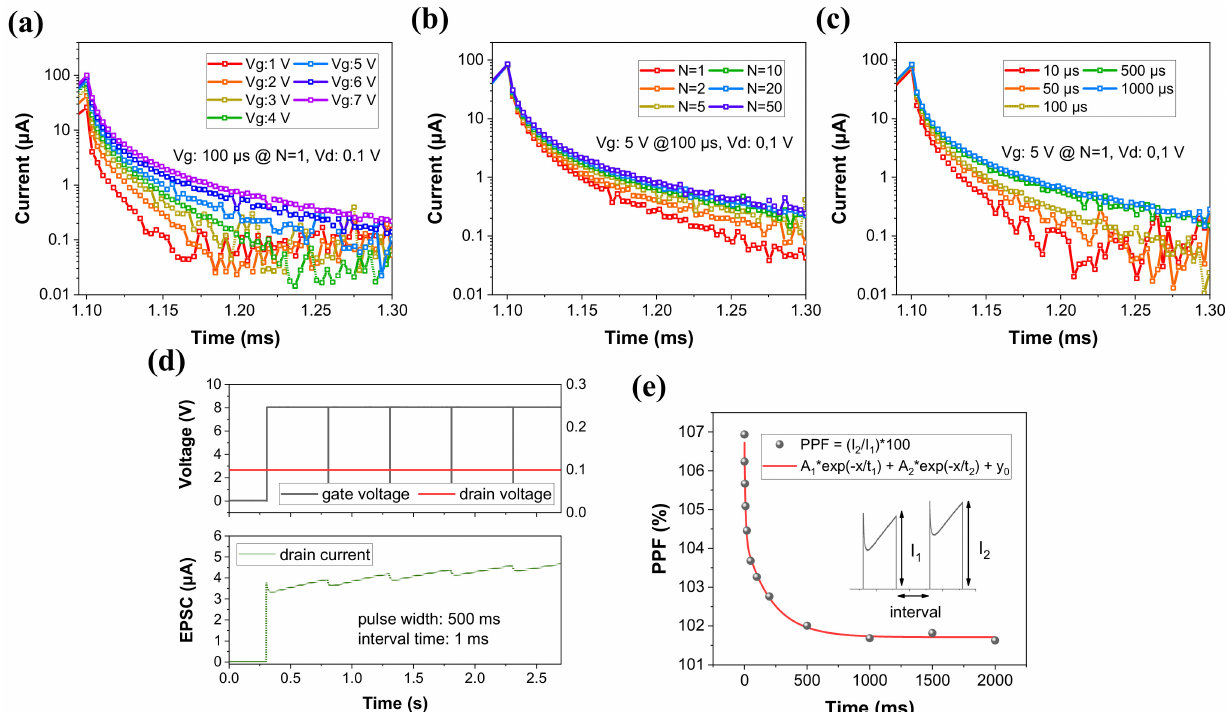
Figure 4. Fired currents at different ( a ) amplitudes, ( b ) pulse numbers, and ( c ) pulse widths. They are identical except for one variable and results at drain voltage of 0.1 V. ( d ) Pulse scheme (top) and EPSC (bottom). To induce EPSC, pulses of 8 V for 500 ms are repeatedly applied at an interval of 1 ms. ( e ) PPF (%); I 2 /I 1 , shows different currents increasing due to the interval time of a